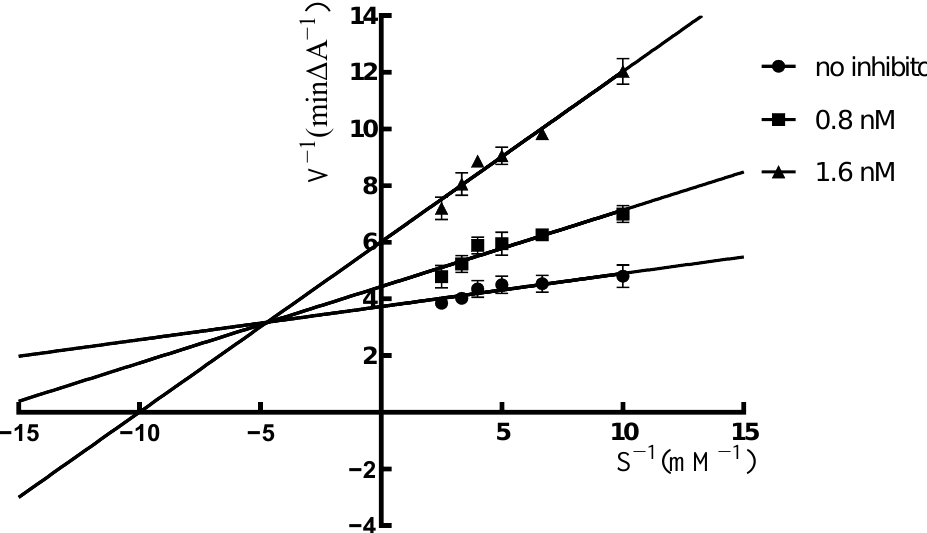
Figure 3. Lineweaver–Burk plots generated from the sub-velocity profiles of acetylcholinesterase activity for different substrate concentrations in the absence or presence of 10a (0, 0.8 and 1.6 nM) (All values are expressed as mean ± SEM from three independent experiments).